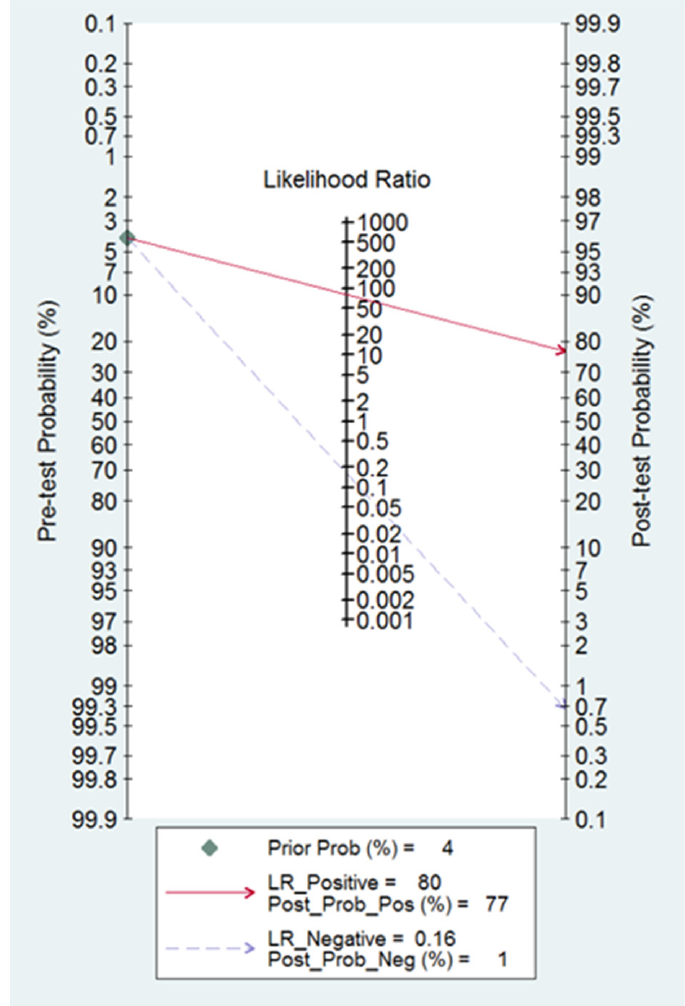
Figure 5. Fagan nomogram for TVS diagnostic accuracy for hydrosalpinx. This shows how depending on the positive or negative TVS diagnosis, the pre-test probability changes.